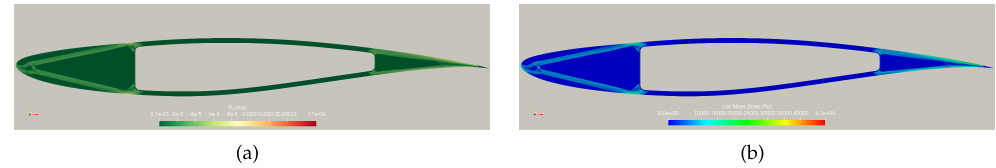
Figure 18. ( a ) Failure index distribution and ( b ) von Mises stress distribution for the topologically optimized structure of case